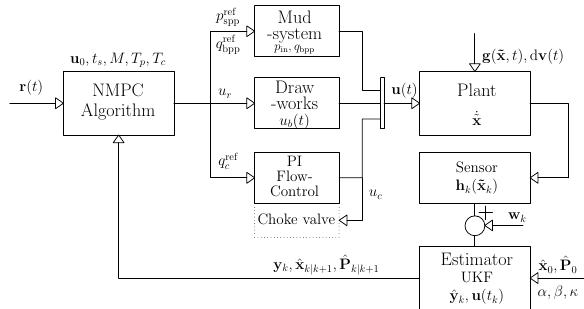
Figure 6: The simulation model. The NMPC predic- tion model comprises of the estimated plant model from (45), leaving the auxiliary system dynamics